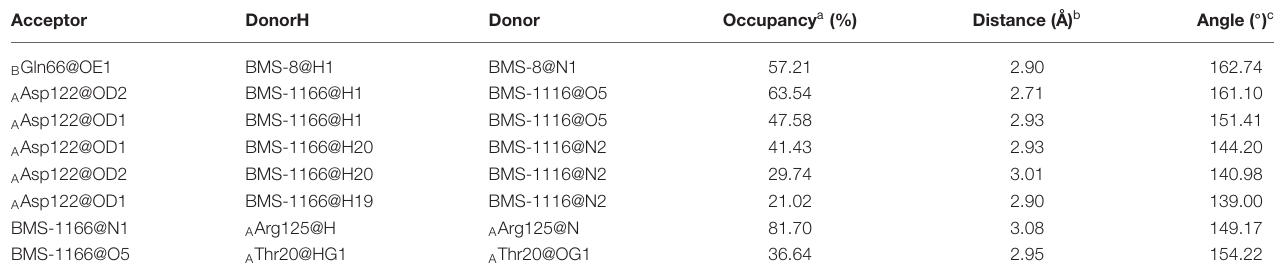
TABLE 3 | The hydrogen bond analysis of the BMS-8 and BMS-1166 dimer